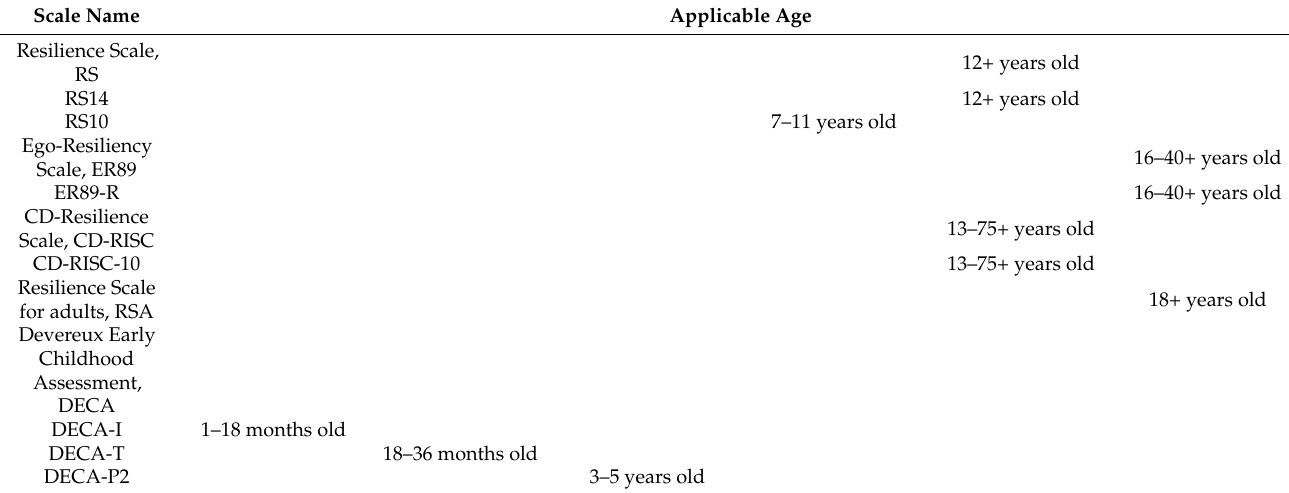
Table 1. Age groups to which different resilience scales were